Question: How would you classify this visualization?
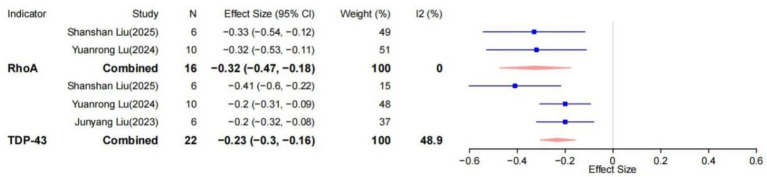
Answer: forest